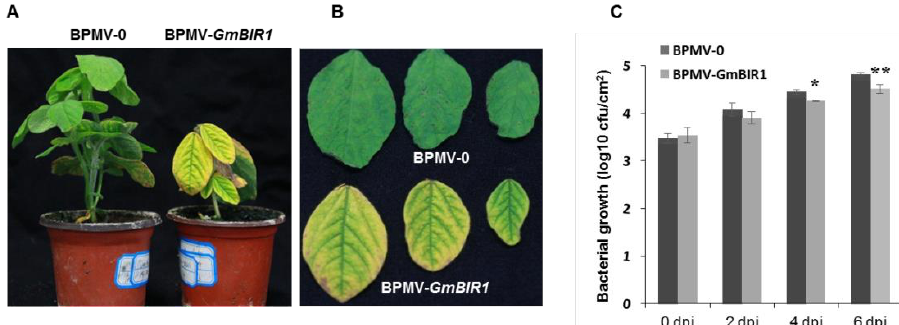
Figure 4. Silencing GmBIR1 enhanced the resistance of soybean plants to Pseudomonas syringae pv. glycinea ( Psg ) R4. ( A ) Comparison of the vector control plants and the GmBIR1 -silenced plants 4 days after spraying Psg suspension; ( B ) Comparison of the leaves from the vector control plants and the GmBIR1 -silenced plants 4 days after spraying Psg ; ( C ) Comparison of the colony forming unit (cfu)between the vector control plants and the GmBIR1 -silenced plants after different days of Psg infection. * and ** represent p < 0.05 and 0.01, respectively (Student’s t -test). This experiment was repeated 2 times with similar